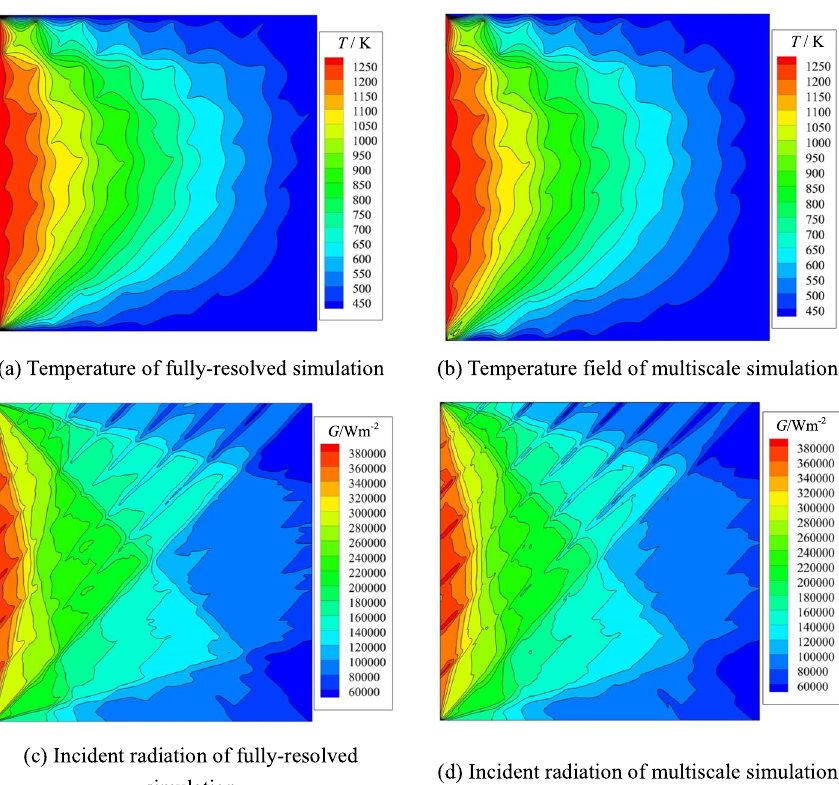
Table 6 Errors of the multiscale simulations for Example 2 Structure Relative error of T 0 Relative Horizontally aligned particle